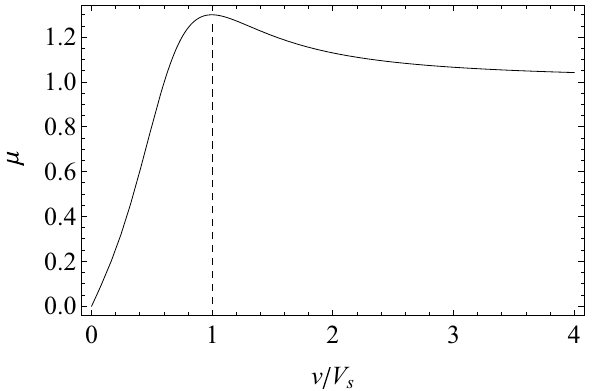
Figure 3. The friction coefficient as a function of the ratio v / V s , with V s being the static velocity tolerance. Parameters are µ s = 1.3 , A = 1.44 , B = − 20